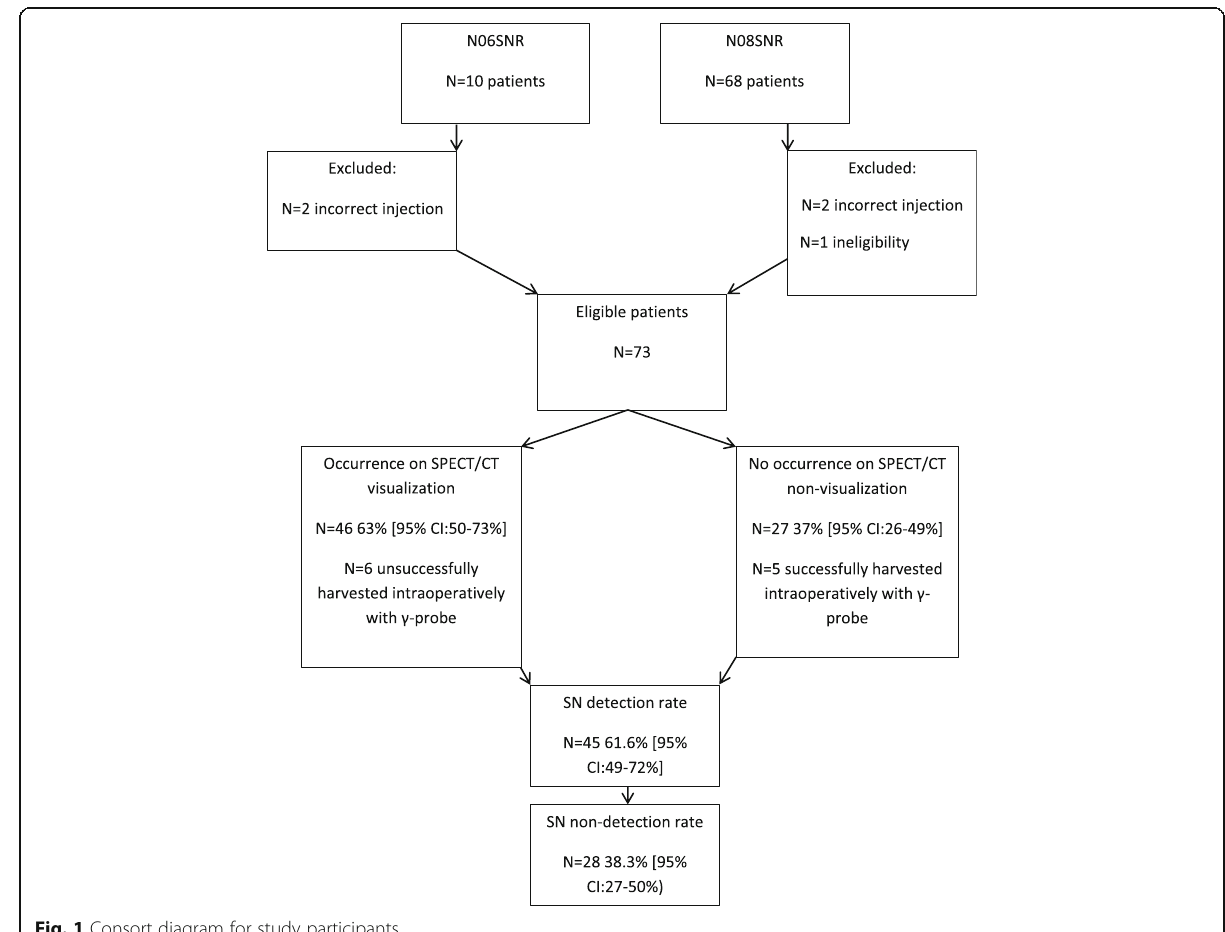
Fig. 1 Consort diagram for study